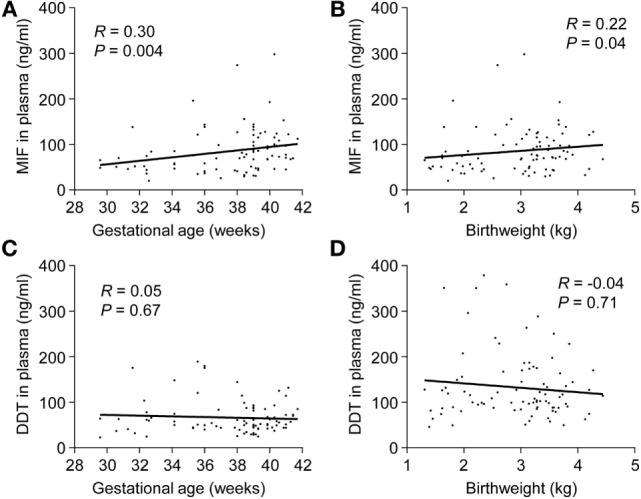
Umbilical cord blood concentrations of macrophage migration inhibitory factor (MIF) and d-dopachrome tautomerase (DDT) in preterm and term newborns. Scatterplot showing MIF (A,B) and DDT (C,D) concentrations in the umbilical vein versus gestational age and birthweight of 30 preterm and 60 term newborns. The regression lines are shown.